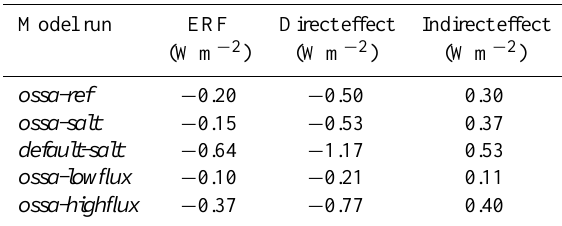
Figure 12. Comparison of observed (AERONET) and modelled ( ossa-ref ) monthly mean AOD in (a) December–January–February (DJF), (b) March–April–May (MAM), (c) June–July–August JJA) and (d) September–October–November (SON). The comparison in- cludes the AERONET island and coastal stations which had data available in the years 2006–2010. The solid black line is the linear regrssion line for all stations. Table 6. Global mean radiative effects (5-year means) in the model runs. ERF stands for effective radiative